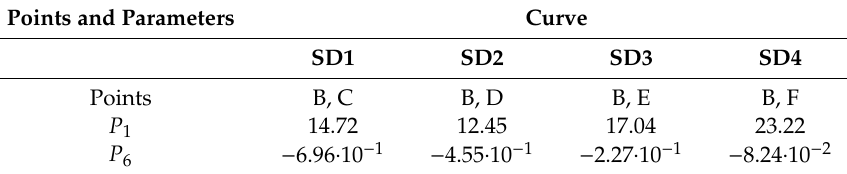
Table 15. P 1 and P 6 for the 9S20 increasing first-order reversal curves. Points and Parameters Curve SI1